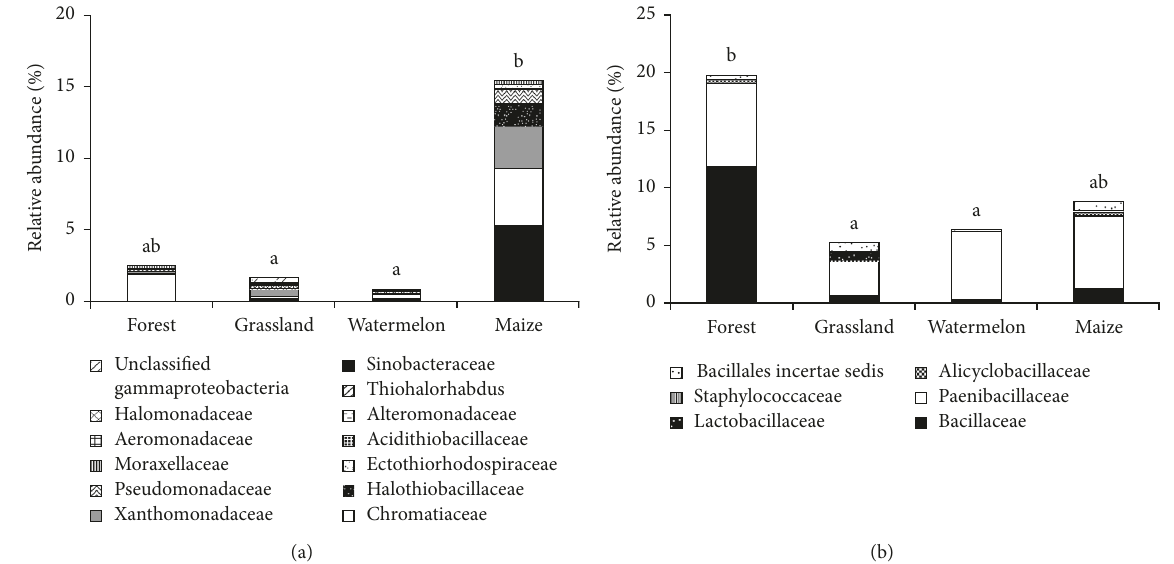
Figure 1: Relative abundances of the bacterial classes (a) Gammaproteobacteria and (b) Bacilli within the soil microbial community under different land use types. The different colours indicate different families within each class. Different lowercase letters above the bars indicate significant differences.